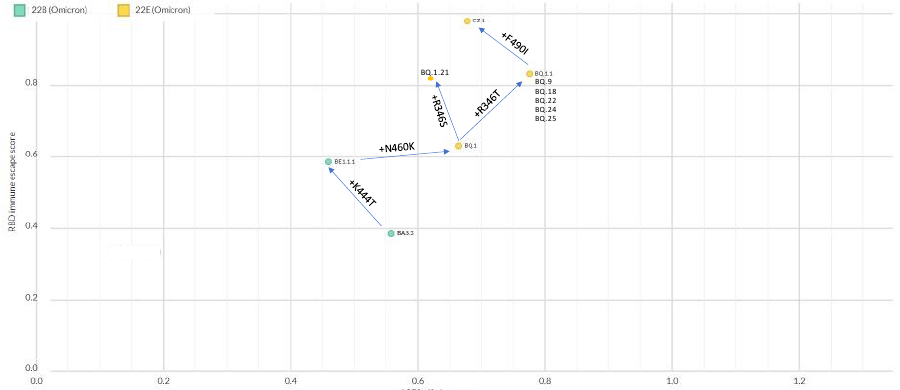
Figure 5. Evolutionary steps at the basis of the major Omicron branches (CZ.1, XBB.* and CH.1.1.1, and other BA.2.75.* descendants), showing progressive increases in RBD immune escape score (as calculated here: https://jbloomlab.github.io/SARS2_RBD_Ab_escape_maps/escape-calc/ (accessed on)). Chart created on NextStrain [31] (https://next.nextstrain.org/staging/nextclade/sars-cov-2/21 L?gmin=15&l=scatter&scatterX=ace2_binding&scatterY=immune_escape&showBranchLabels=all (accessed on 26 December